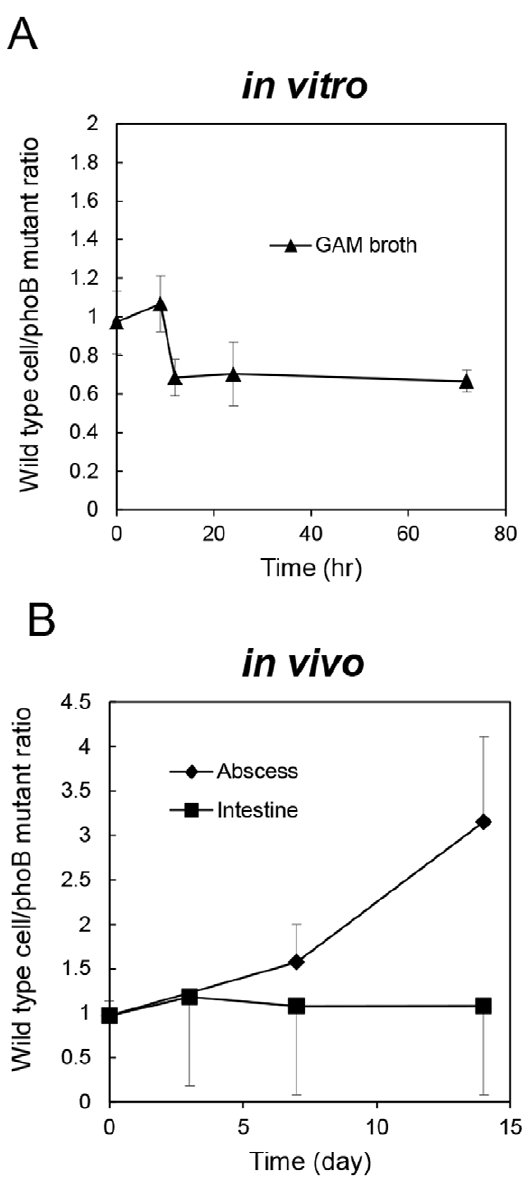
Figure 8. Competitive growth assay of wild type and D phoBB. fragilis strains in vitro (A) and in vivo (B). These strains were equally mixed and inoculated into GAM broth, mice intestines or the peritoneal cavity. After periodical sampling from liquid culture, feces and abscesses, samples were spread on GAM agar plates, and the population levels of wild type and D phoB B. fragilis strains were evaluated by discriminating colony PCR. The data were expressed as wild type/ D phoB mutant ratios. The ratios of wild type and phoB mutant strains in the intestine and abscess were compared by Chi-square test.